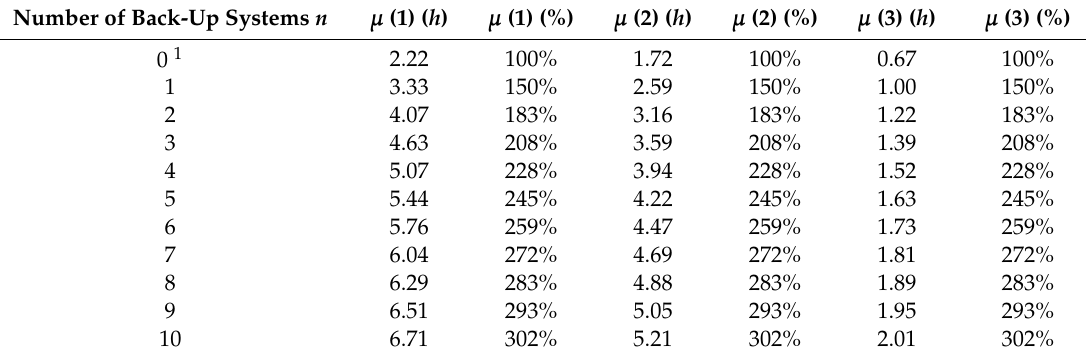
Table 1. Comparison of lifetimes for di ff erent system configurations depending on number of backup systems.